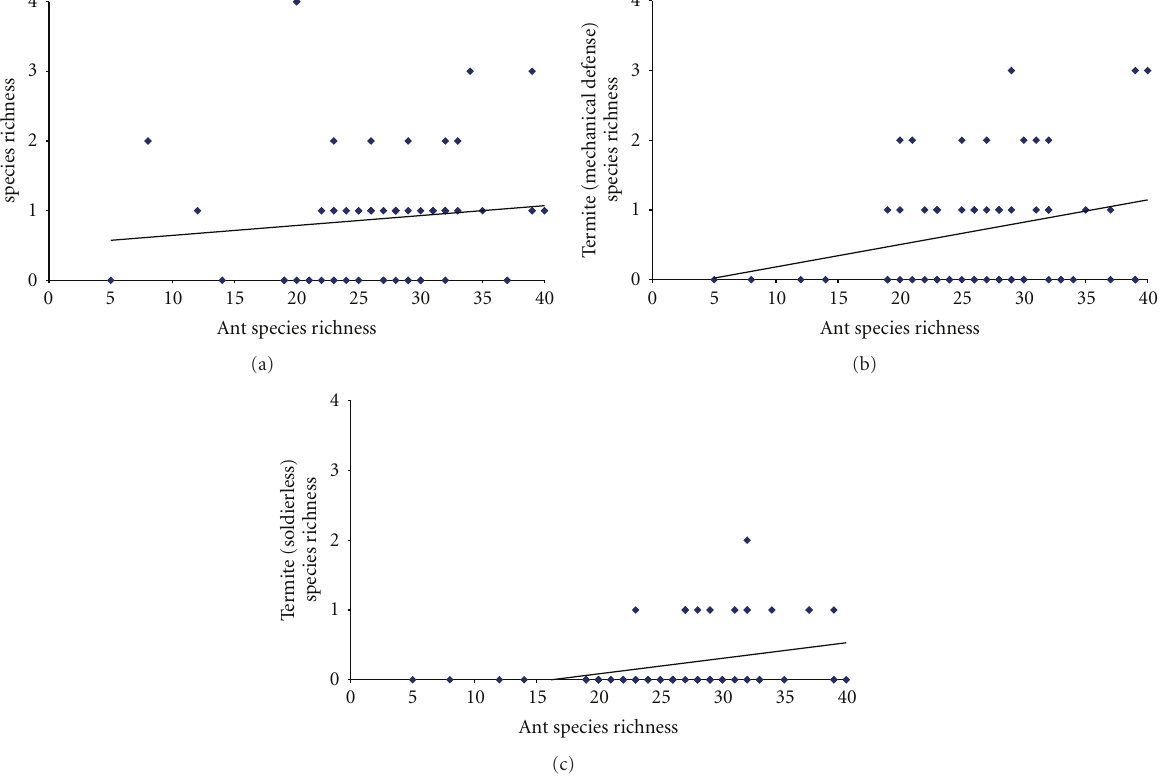
Figure 4: Correlation between ant species richness and (a) the species richness of termites with chemical defense (Spearman’s Rho = 0.195, P = 0 . 136, n = 60), (b) the species richness of termites with mechanical (mandibular) defense (Spearman’s Rho = 0.159, P = 0 . 225, n = 60), and (c) the species richness of soldierless termites ( Anoplotermes and Ruptitermes ) (Spearman’s Rho = 0.379, P = 0 . 003, n = 60).